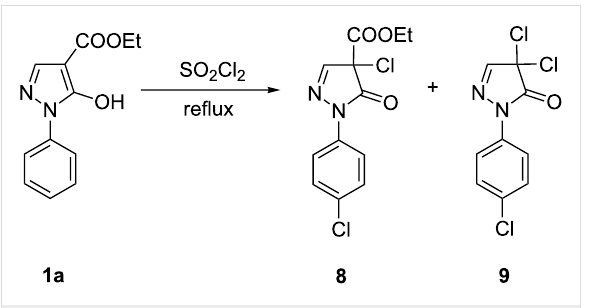
Scheme 5: Reaction of 1a with sulfuryl